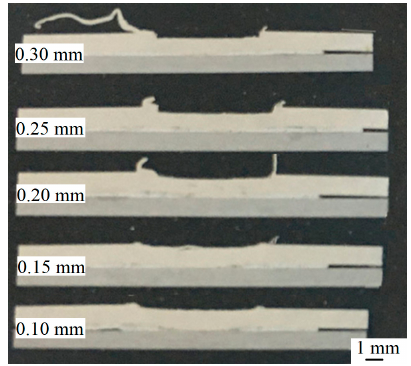
Figure 5. Macroscopic morphology of weld cross section.